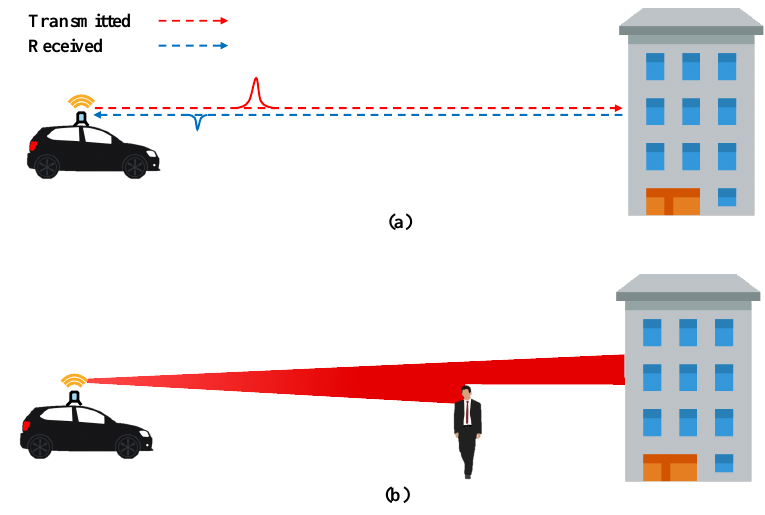
Figure 4. Light detection and ranging (LiDAR) measurement characteristics: ( a ) Time-of-flight (ToF) and ( b ) laser beam divergence and